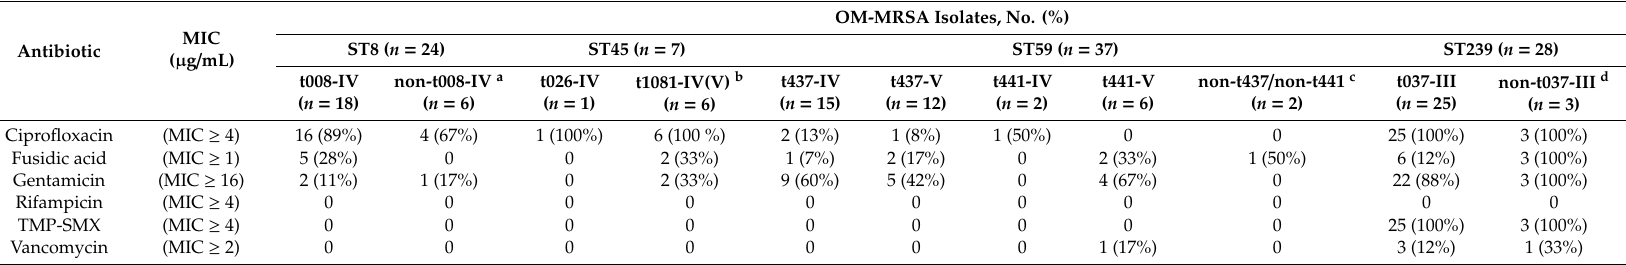
Table 7. Association between the antibiotic resistance profiles and the genotypes for OM-MRSA